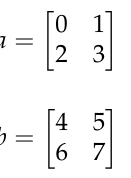
Figure 10. Input arrays a and b .